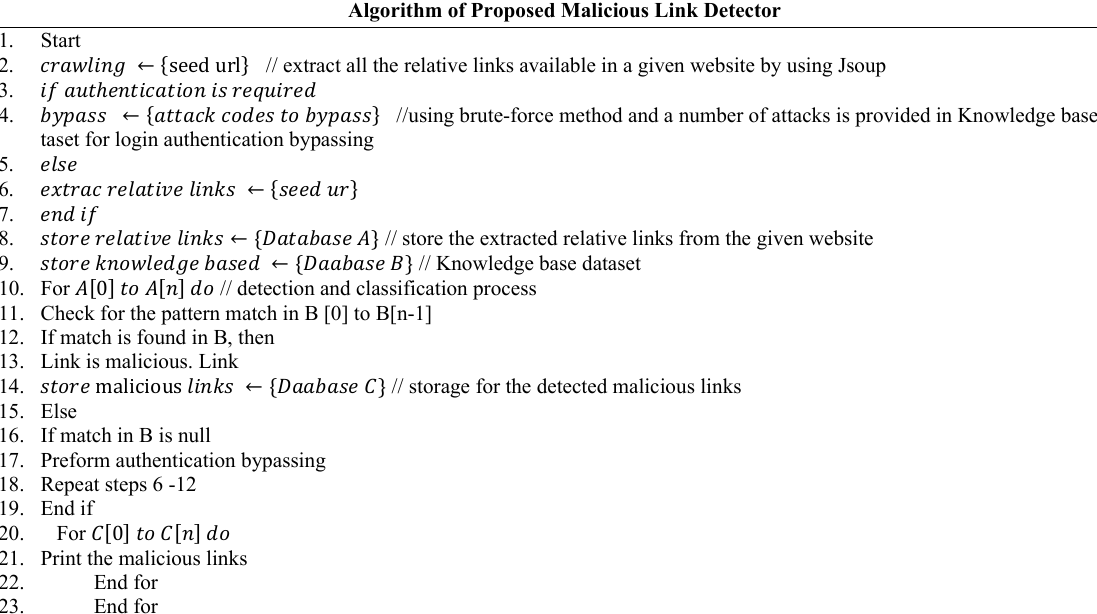
Algorithm of Proposed Malicious Link